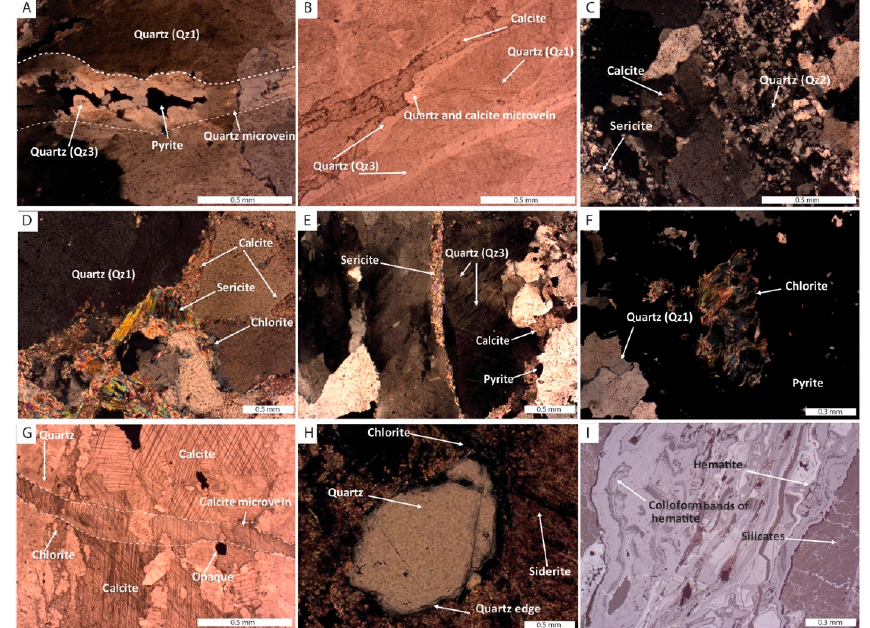
and pyrite; ( F ) Chlorite cavity filling in pyrite and quartz 1; ( G ) Calcite microvein is cutting rhombic calcite; ( H ) Quartz-chlorite-siderite mineral association; ( I ) Colloform bands of hematite in supergene